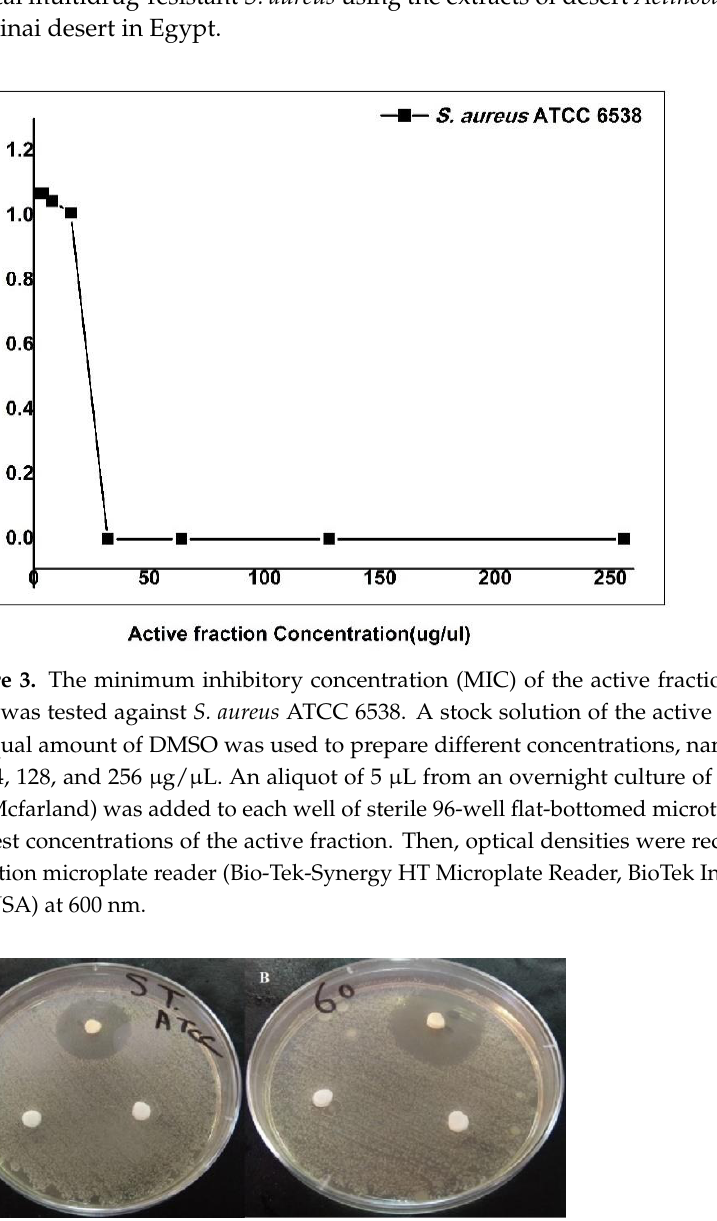
Figure 4. The inhibitive activity of compound 3 isolated from Streptomyces sp. DH7 against ( A ) S. aureus ATCC 6538 and ( B ) multidrug-resistant S. aureus No. 60 via the agar disc-diffusion method. Petri dishes were then incubated for 24 h at 37 °C and then the inhibition zone areas were recorded. All tests were performed in duplicates.